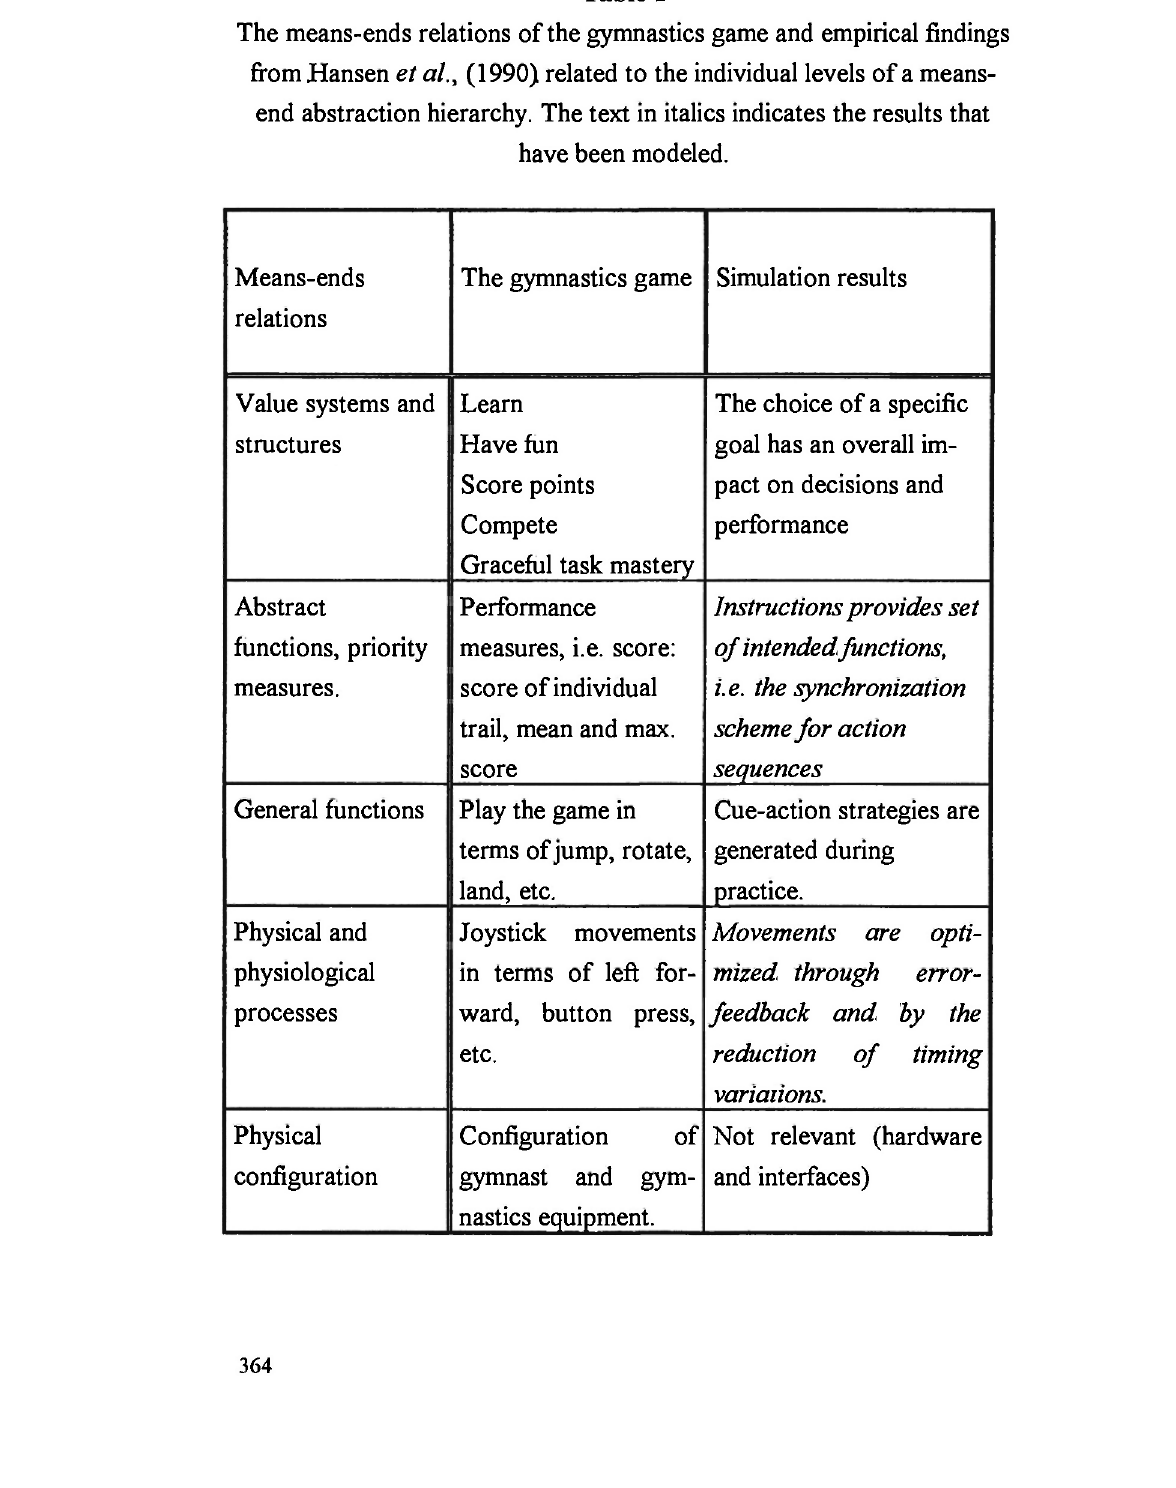
The means-ends relations of the gymnastics game and empirical findings from Hansen et al., (1990) related to the individual levels of a means- end abstraction hierarchy. The text in italics indicates the results that have been